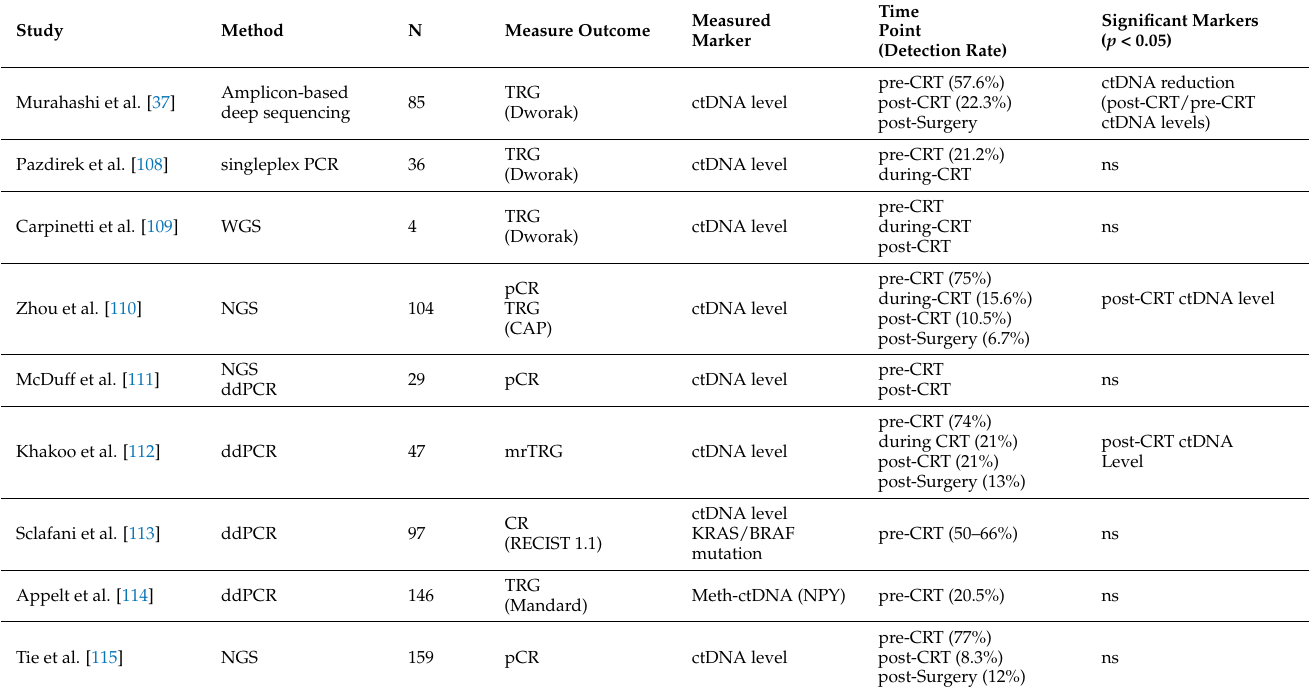
Table 4. Studies exploring ctDNA as a biomarker predictive of tumor regression following CRT.